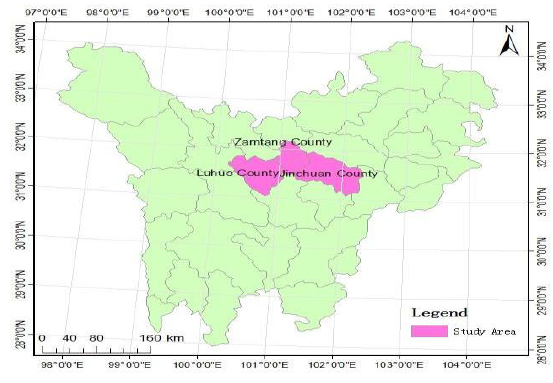
Figure 1. Overview of the study area Both Jinchuan County and Luhuo County are typical hardship areas in China. Both counties are typical semi-agricultural and pastoral counties. With dense forests, the two counties are key original forest areas in the southwest and one of the important water conservation areas in the upper reaches of the Yangtze River. The main economic pillars of the past in the study area wood harvesting has been greatly reduced. Combined with the policy of returning farmland to forests, the area of